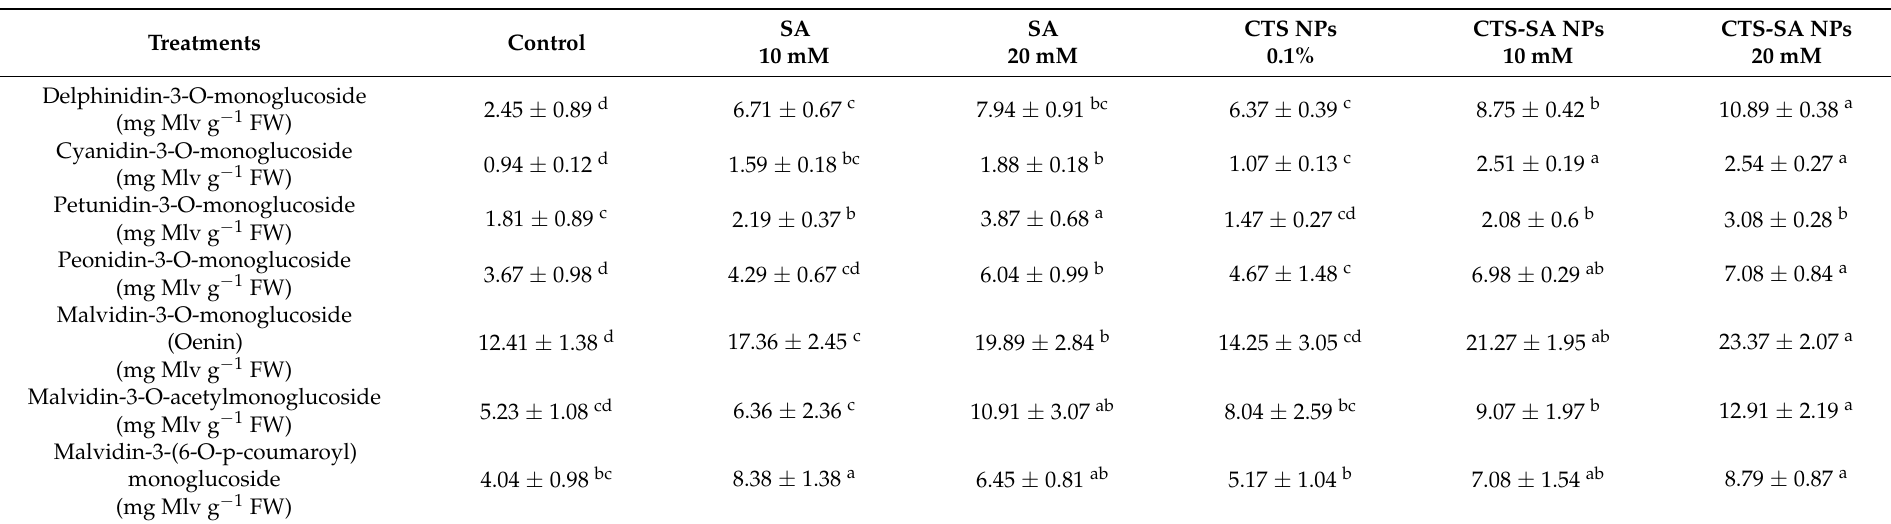
Table 2. The effect of salicylic acid (SA) (10 and 20 mM), chitosan (CTS) (0.1%), and their combination in nano-form (CTS-SA NPs) treatments on some anthocyanins, particularly malvidin-3- O -b glucoside (oenin) of grape ( Vitis vinifera L.) cv. Red Sultana based on the HPLC chromatogram. The anthocyanin was isolated by the solid phase extraction of C-18 cartridges using 5% formic acid and methanol in a linear gradient from 15 to 35% for 15 min, followed by isocratic elution for 20 min. Different letters indicate significantly different values at p ≤